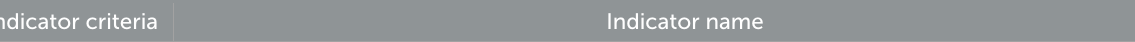
TABLE 1 Community’s aging construction